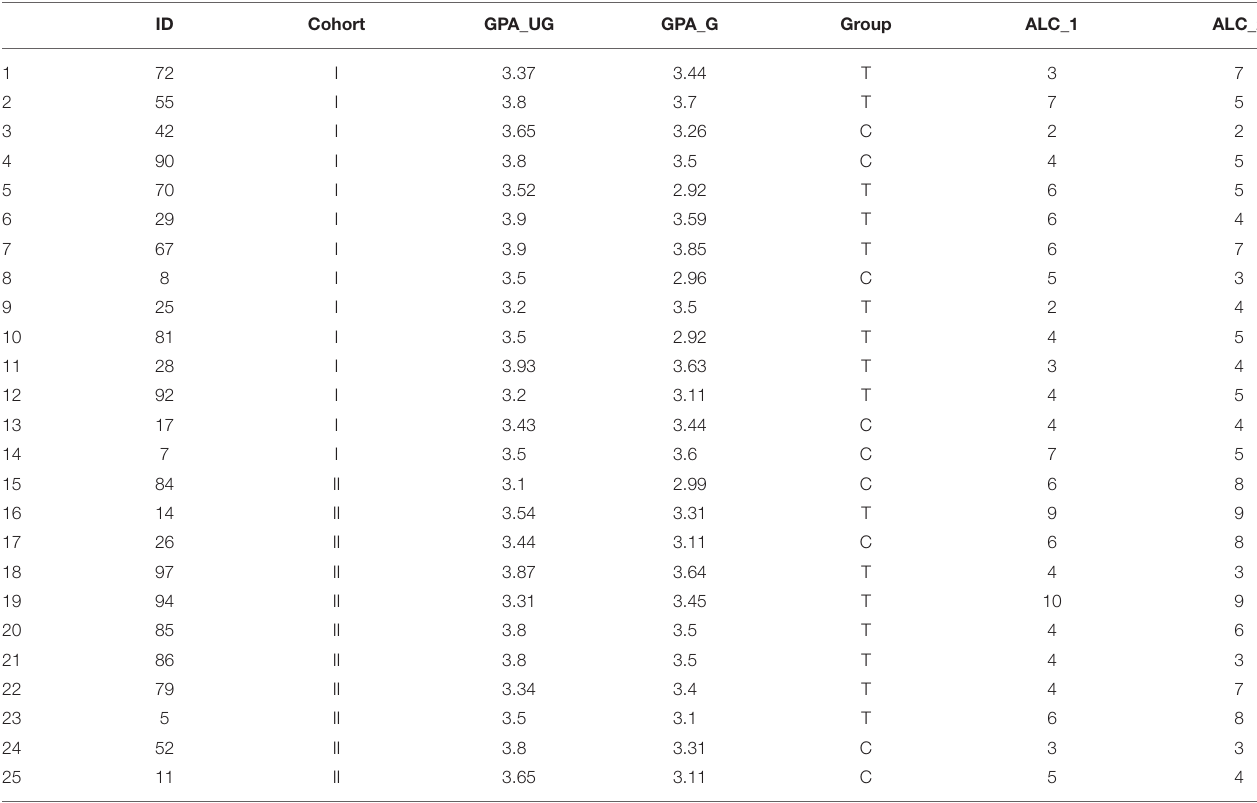
TABLE 3 | Responses to academic locus of control (ALC) questionnaire 15 weeks